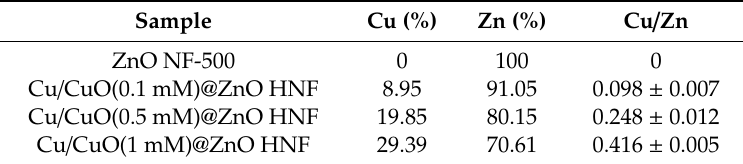
Figure 4. Energy dispersive X-ray spectroscopy (EDX) mapping images (left) and SEM images (right) of Cu / CuO-photodeposited ZnO hollow nanofibers (Cu / CuO@ZnO HNFs) with di ff erent concentrations of CuAc 2 : ( a ) 0 mM; ( b ) 0.1 mM; ( c ) 0.5 mM; ( d ) 1 mM. Table 1. Elemental composition of Cu / CuO@ZnO